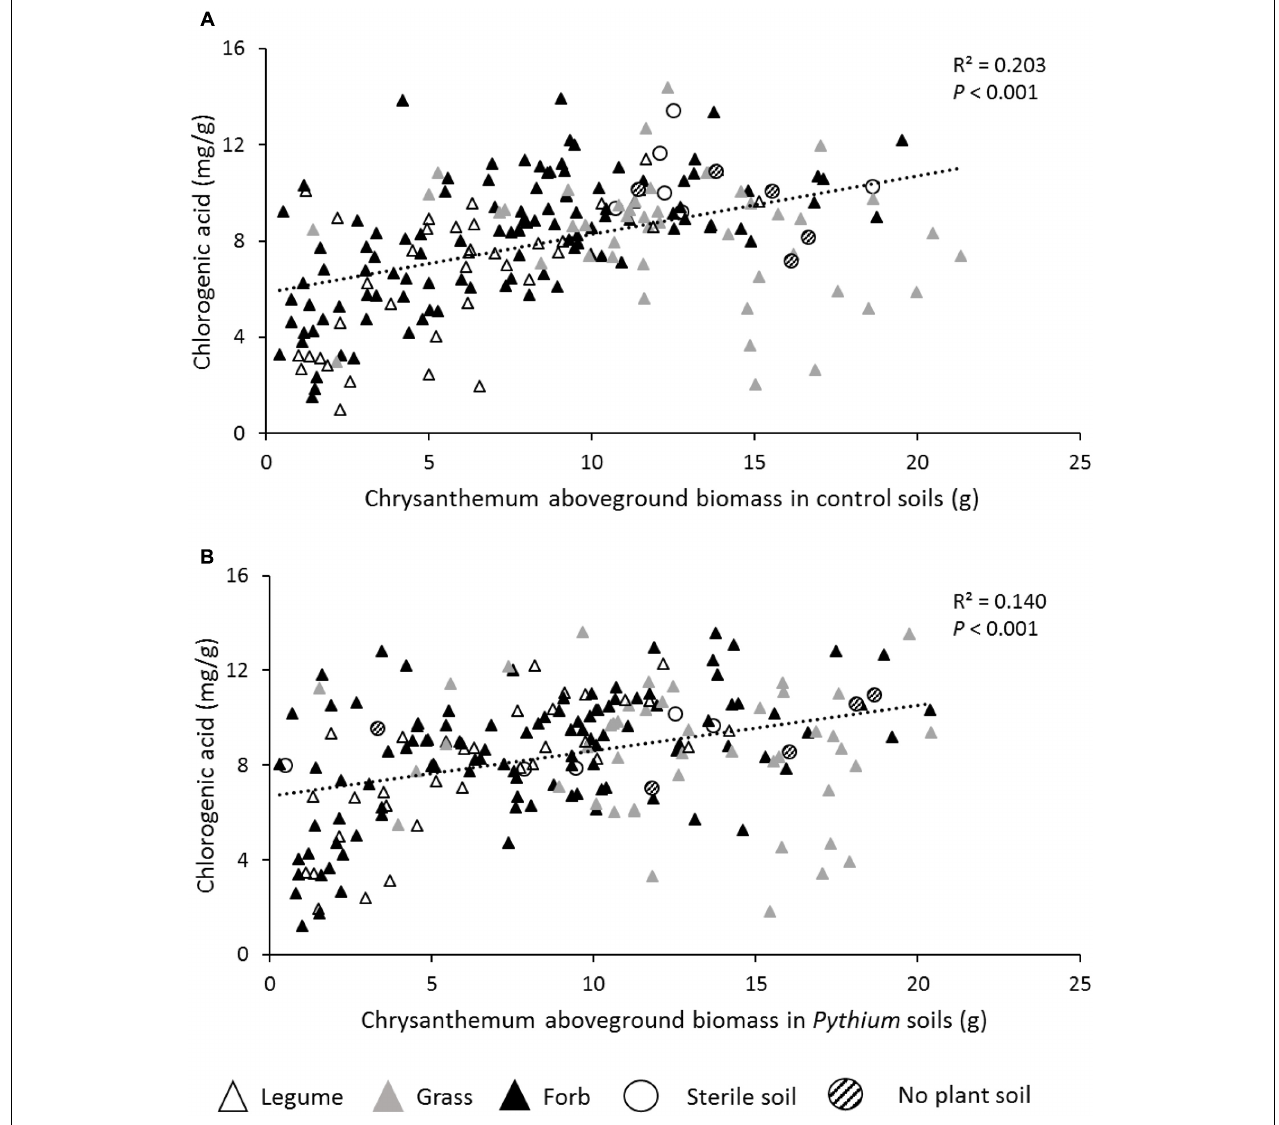
FIGURE 4 | Relationships between chrysanthemum leaf chlorogenic acid concentration and aboveground biomass in control soil (A) , and Pythium added soils (B) . Black triangles represent forb inocula; Gray triangles represent grass inocula; White triangles represent legume inocula; White circles represent 100% sterile soil; Striped circles represent no plant